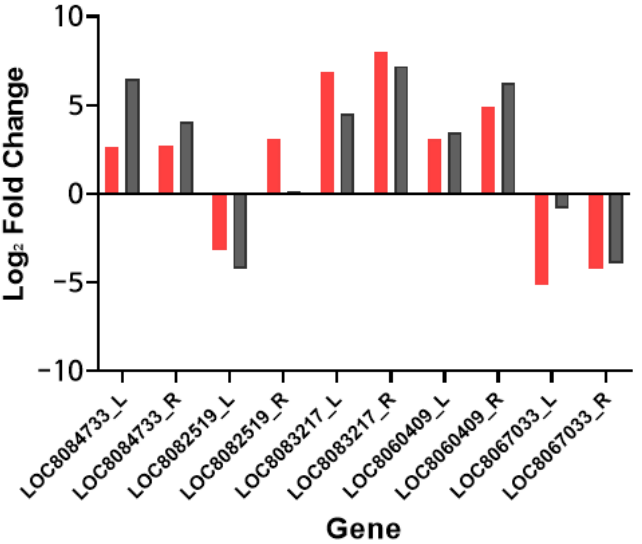
Figure 6. Validation of five DEGs using qRT-PCR. The pink bars correspond to qRT-PCR and the gray bars correspond to RNA-Seq. The x -axis represents genes and the y -axis represents log 2 fold change. L and R after the gene names represent leaves and roots, respectively.